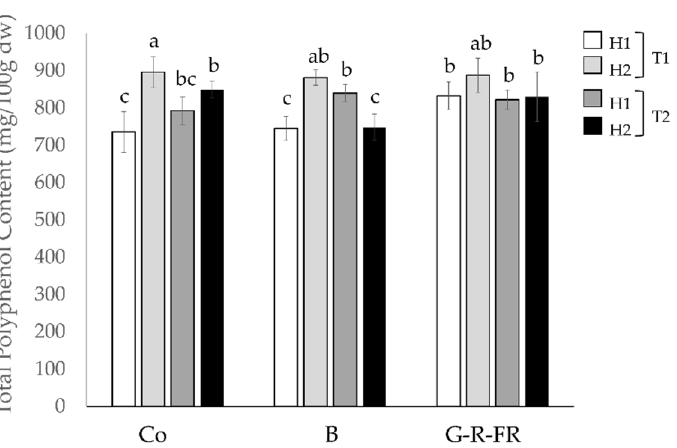
Figure 1. Total polyphenol content of broccoli samples measured in dry weight across all harvests and light treatments. H in the legend relates to harvest number and T to trial number. Co (control), B (blue), G-R-FR (green/red/far-red). The different letters represent significant differences between samples ( p < 0.05).